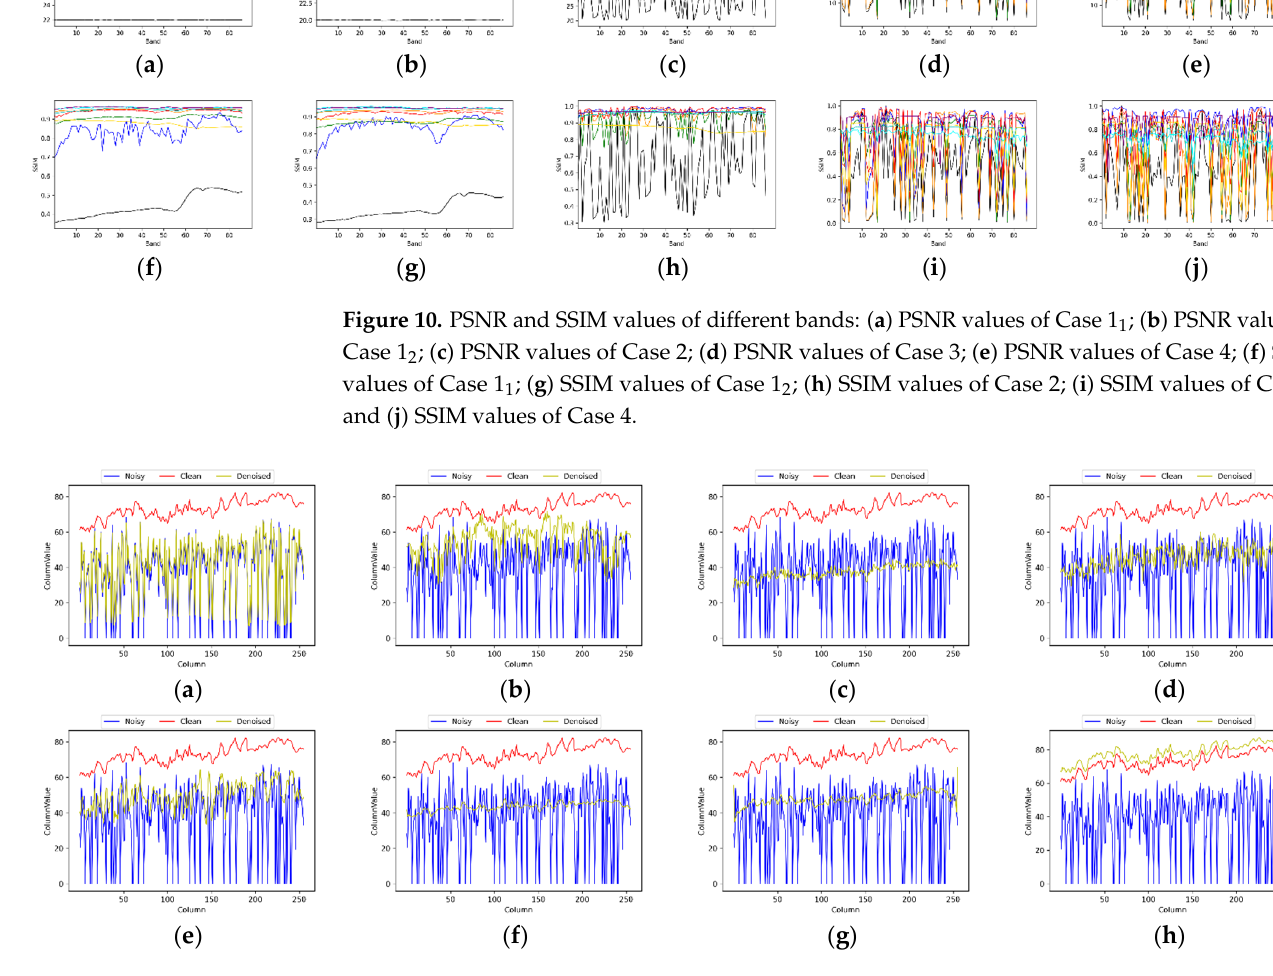
Figure 11. Recovery of bad lines by different denoising algorithms in band 83: ( a ) BM4D; ( b ) LRMR; ( c ) HyRes; ( d ) L1HyMixDe; ( e ) DHP-2D; ( f ) SIP; ( g ) SURE-CNN; and ( h ) 3S-HSID.